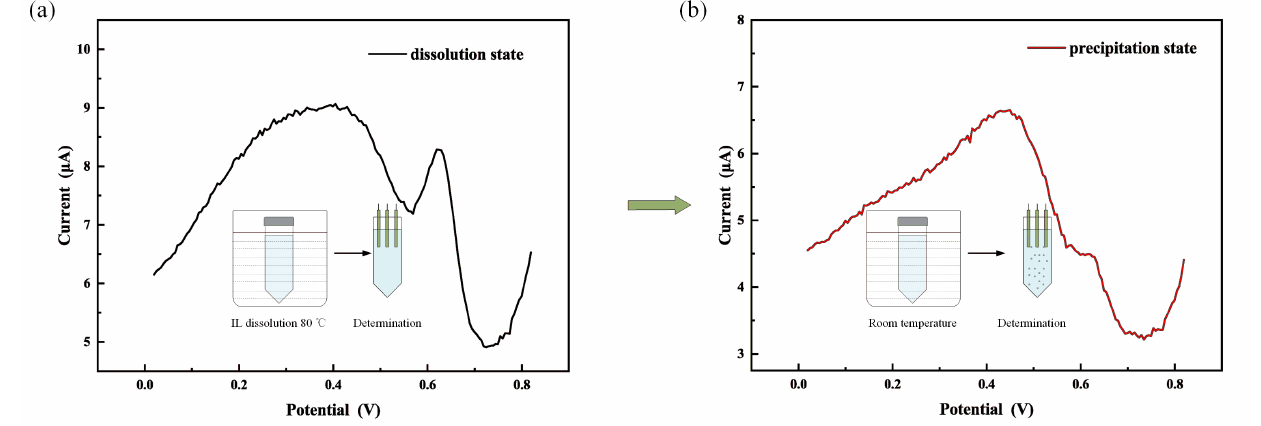
Figure 3. Solution appearance and DPSV signal of mercury during TC-DLPME; ( a ) IL is completely dissolved in the sample; ( b ) IL is separated from the sample. The initial solution contains 100 µ gL − 1 Hg 2 + and deposited potential was 0 V, and the deposited time was the 60